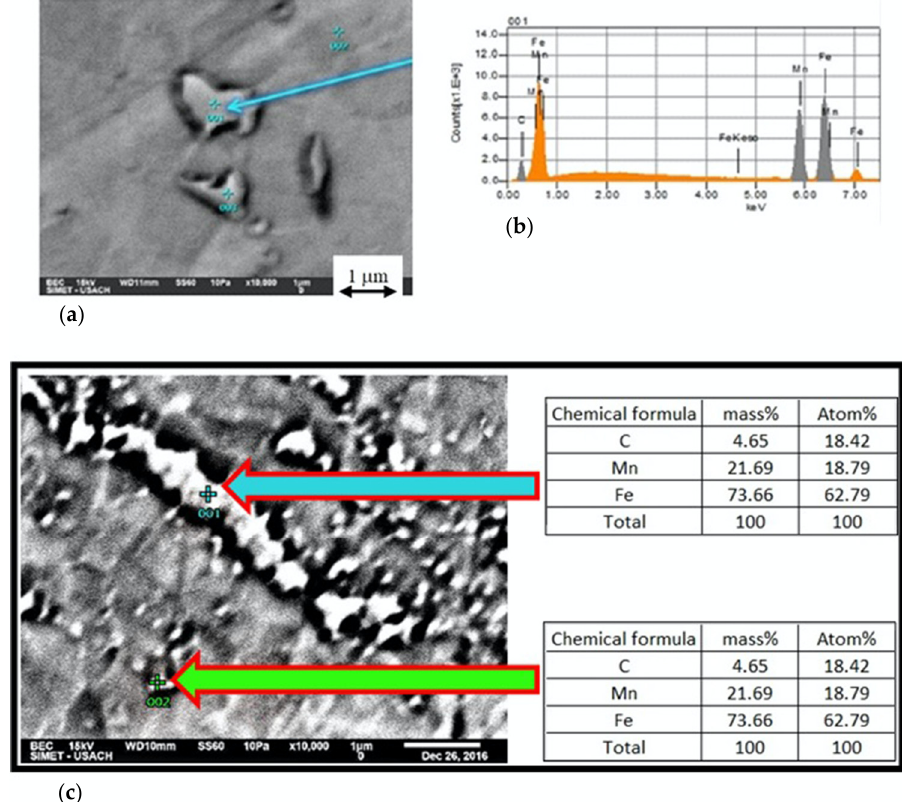
Figure 4. ( a ) Carbides, ( b ) diffractogram of a carbide, ( c ) carbides with EDS results.